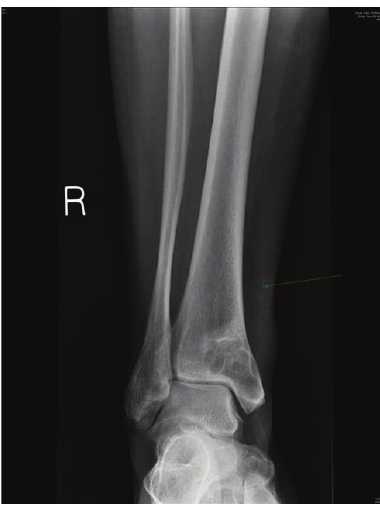
Figure 2: AP X-ray of ankle showing cystic lesion in distal tibia.